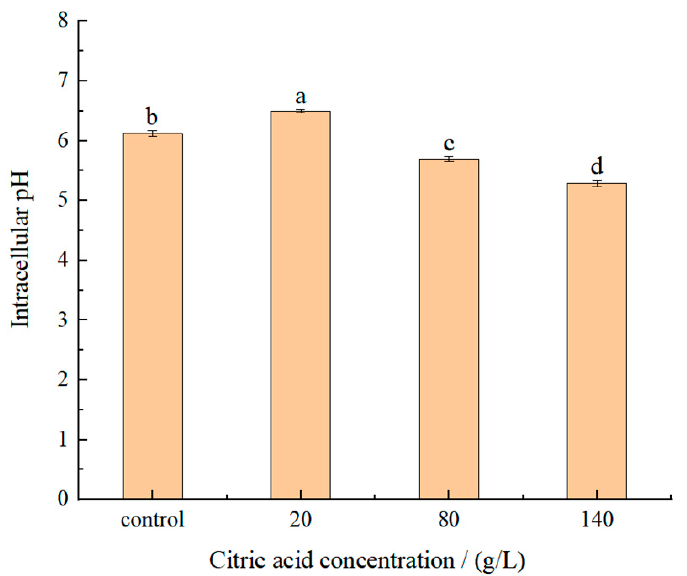
Figure 2. Intracellular pH in different citric acid concentrations of I. terricola WJL-G4. Error bars: SD ( n = 3). Statistically significant differences ( p < 0.05) were determined by one-way ANOVA with Duncan’s test and were indicated with different letters.